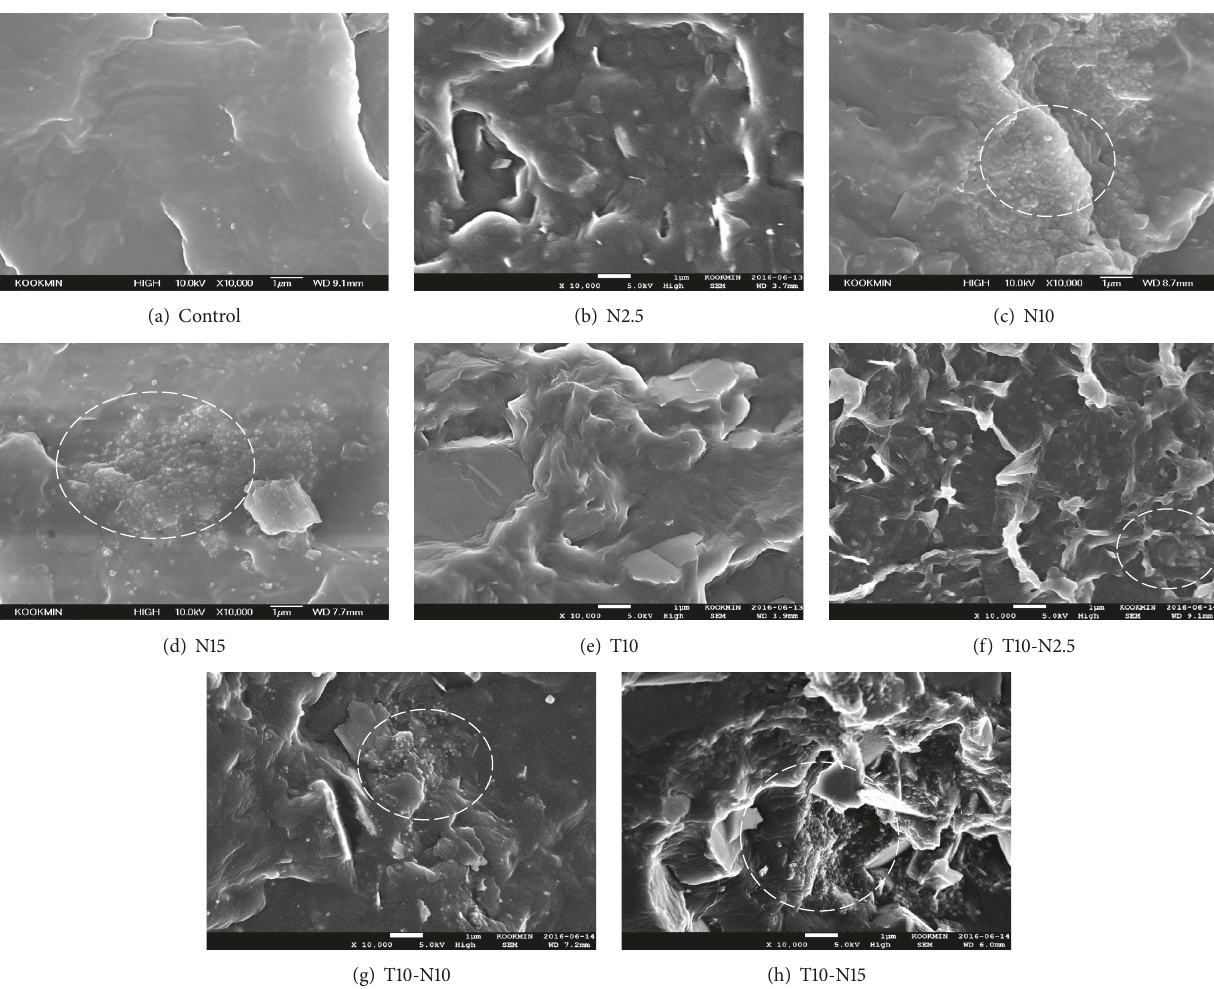
Figure 7: SEM images of control, NCC-only, and NCC-talc hybrid filled PP-based composites.